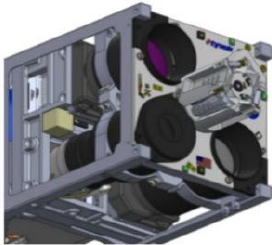
Figure 25. RPOD module diagram.